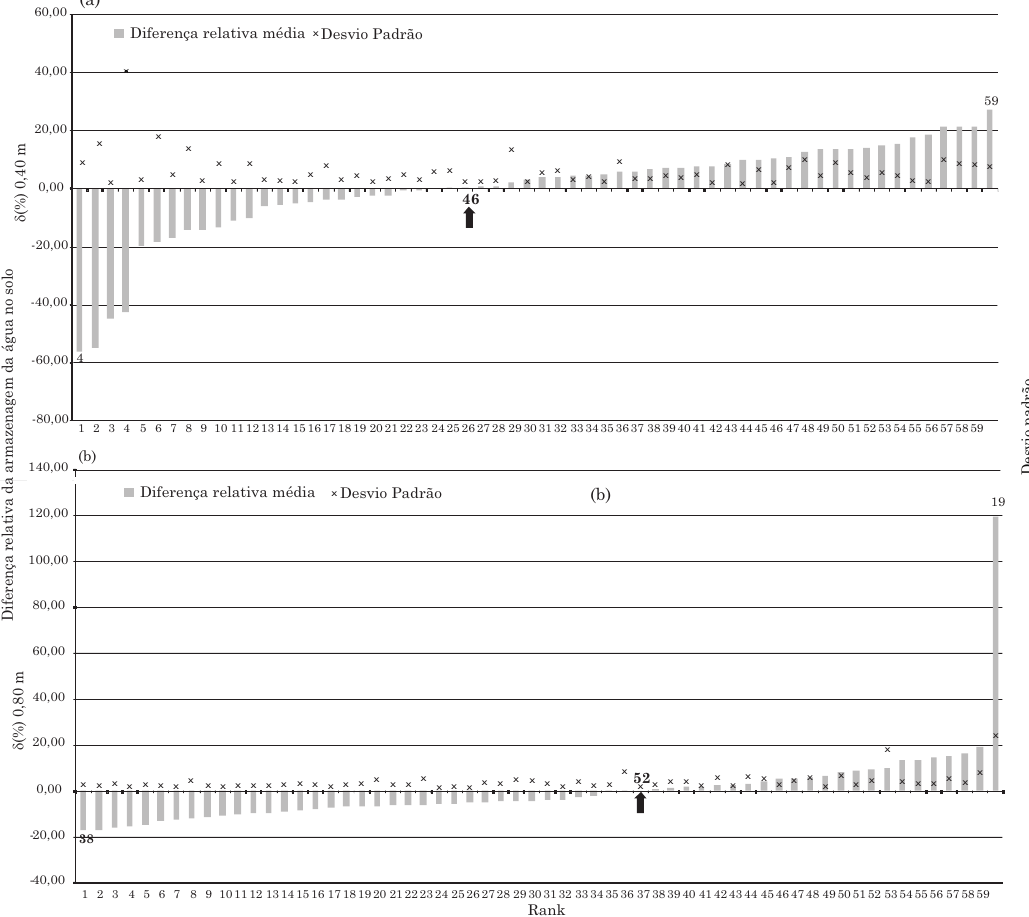
Figura 5. Diferença relativa média no tempo para a armazenagem de água no solo a 0,40 (a) e 0,80 m (b) e respectivo desvio-padrão no tempo obtido durante o ciclo da aveia-preta. Números referem-se aos pontos de medida.